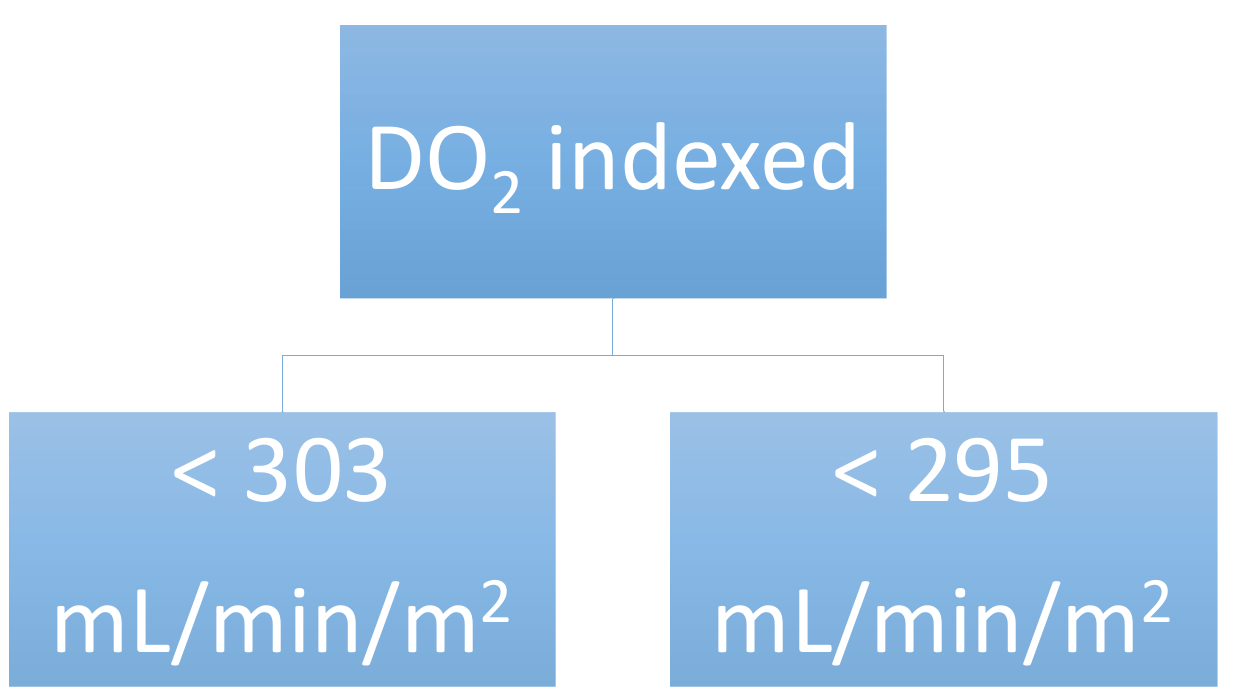
Figure 1. Decision-making analysis using the Classification and Regression Tree (CART) analysis, categorizing the kidney oxygen delivery index with an increased chance of developing acute renal injury after heart surgery.